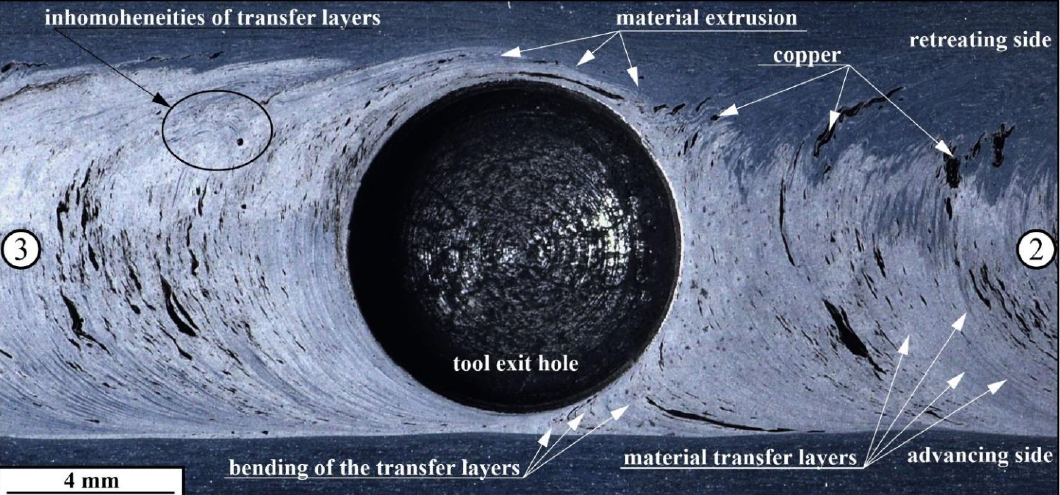
Figure 9. The enlarged X-ray computer tomography in-plane images of samples with 6 ( a ) and 15 vol.% ( b ) Cu obtained from samples with 1 to 4 passes after FSP. Taking into account the XCT images obtained from the 6.0 vol.% Cu sample, it could be suggested that the copper particle dispersion in the AA5056 stir zone occurs synchro- by images in Figure 11c, where large copper particles do not disappear even after the fourth nously with the plasticized metal transfer, i.e., with highly efficient stirring provided by FSP pass. the combination of adhesion transfer and extrusion (Figure 10).